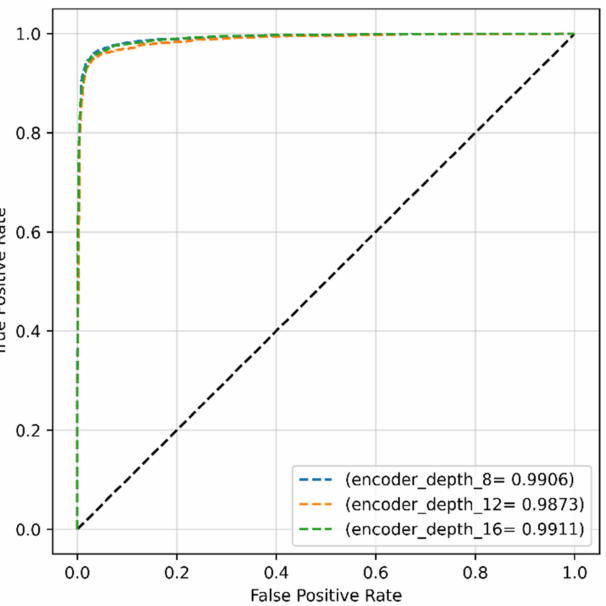
Figure 12. ROC curves of the proposed model obtained with original dataset and encoder depths of 8, 12, and 16.